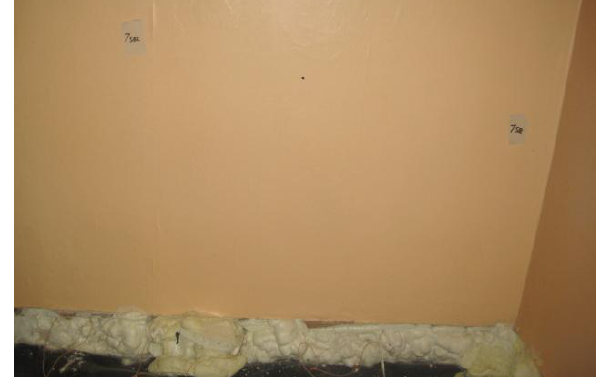
Figure 14. Leak of the foam at the bottom pat of the wall